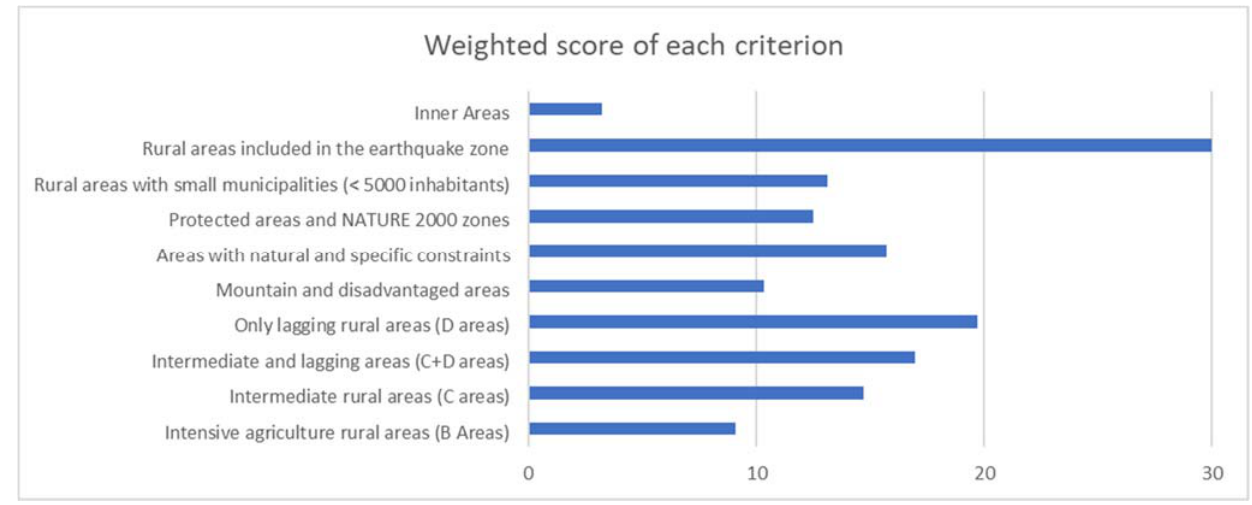
Figure 5. Weighted score of investment criteria by type of criterion. Source: authors’ elaborations from the data base of calls for tender.